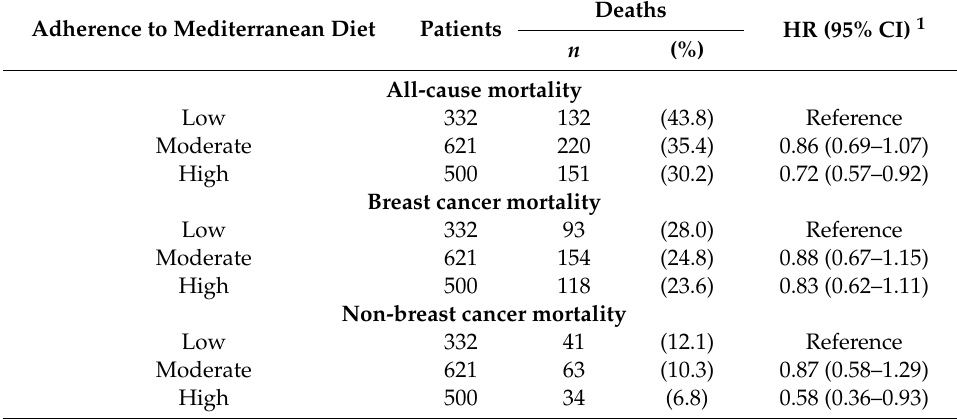
Figure 2. Kaplan–Meier estimates of cumulative incidence of breast cancer and non-breast cancer mortality according to adherence to Mediterranean diet.